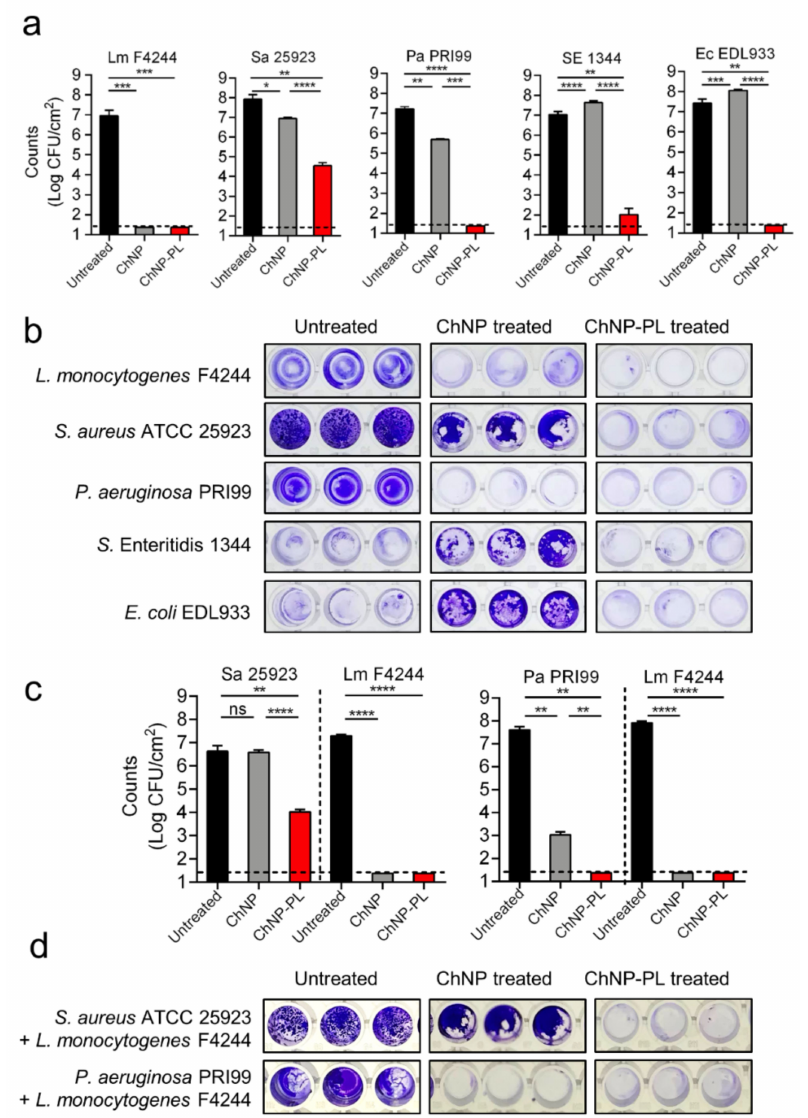
Figure 6. Assessment of the prevention of biofilm formation by ( a , b ) monoculture or ( c , d ) mixed cul- tures by chitosan nanoparticles (ChNP) or chitosan nanoparticles conjugated to ε -poly-L-lysine (ChNP-PL) on five foodborne pathogens, L. monocytogenes (Lm) F4244, S. aureus (Sa) 25923, P. aeruginosa (Pa) PRI199, S . Enteritidis (SE) 1344, and E. coli (Ec) O157:H7 EDL933. Panels are ( a ) bacterial counts, ( b ) crystal violet staining of monoculture biofilms in a microtiter plate, and ( c ) bacterial counts and crystal violet staining of mixed culture biofilms of Lm and Sa, or Lm and Pa with ChNP or ChNP-PL. Bacteria isolated from biofilms were quantified by the plating method. A pairwise Student’s t -test was used for statistical analysis. * p < 0.005, ** p < 0.005, *** p < 0.0005, **** p < 0.0001. Dotted lines represent the detection